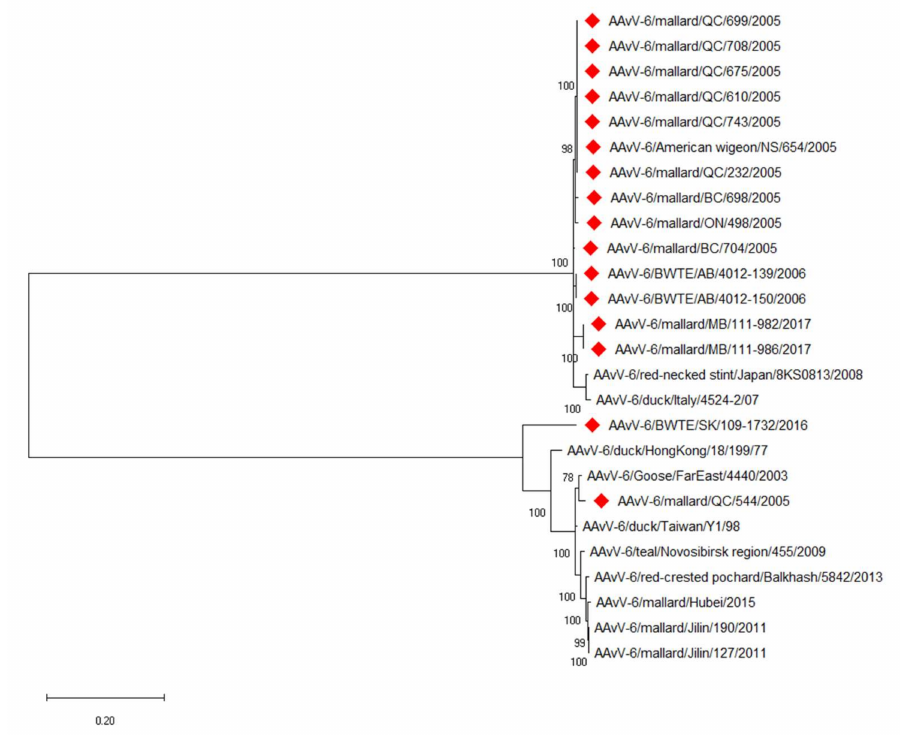
Figure 1. Phylogenetic analysis of the whole genome sequences of AAvV-6 viruses. Viruses described in this study are denoted by red diamonds. The evolutionary history was inferred by using the Maximum Likelihood method based on the General Time Reversible model. The tree with the highest log likelihood ( − 61096.09) is shown. The percentage of trees in which the associated taxa clustered together is shown next to the branches. Initial tree(s) for the heuristic search were obtained automatically by applying Neighbor-Join and BioNJ algorithms to a matrix of pairwise distances estimated using the Maximum Composite Likelihood (MCL) approach, and then selecting the topology with superior log likelihood value. A discrete Gamma distribution was used to model evolutionary rate differences among sites (5 categories (+ G , parameter = 0.6440)). The rate variation model allowed for some sites to be evolutionarily invariable ([+ I ], 31.21% sites). The tree is drawn to scale, with branch lengths measured in the number of substitutions per site. The analysis involved 26 nucleotide sequences. There were a total of 16,420 positions in the final dataset. Evolutionary analyses were conducted in MEGA